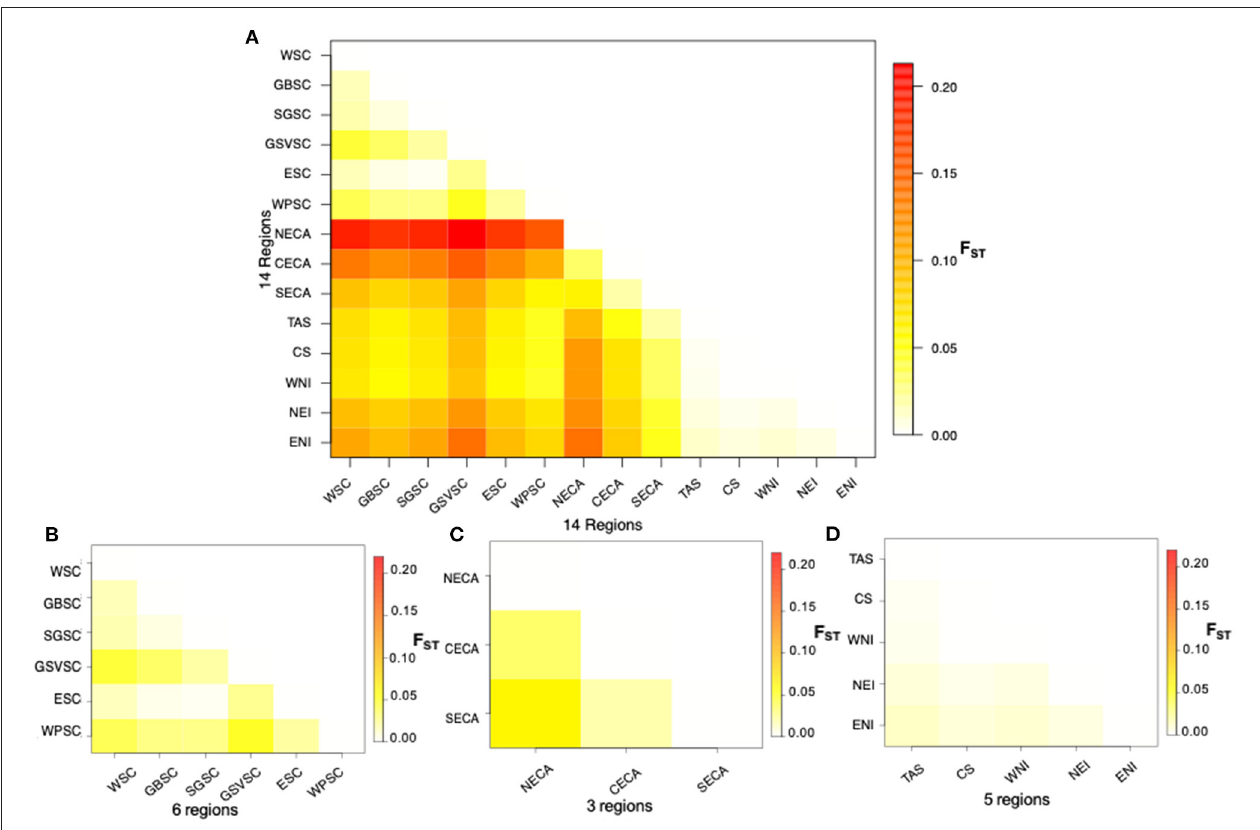
FIGURE 3 | Heatmap of pairwise F ST values between localities* based on 14,799 SNPs for Australasian common dolphins ( Delphinus delphis ); (A) Australia and New Zealand; (B) Southern coast of Australia; (C) Eastern coast of Australia; and (D) New Zealand and Tasmania. *Acronyms used as in Figure 1 .